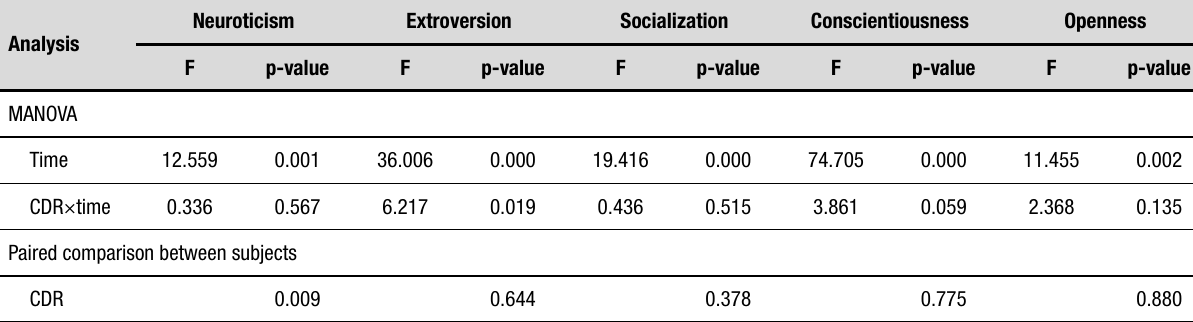
Table 3. Comparative analysis between the